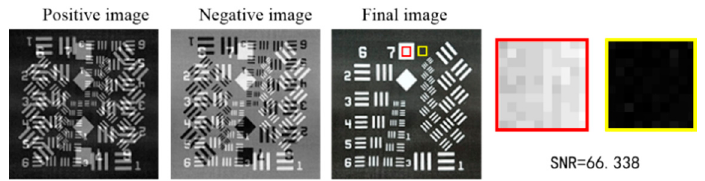
Figure 6. Experimental results based on Fourier positive–negative intensity correlation.